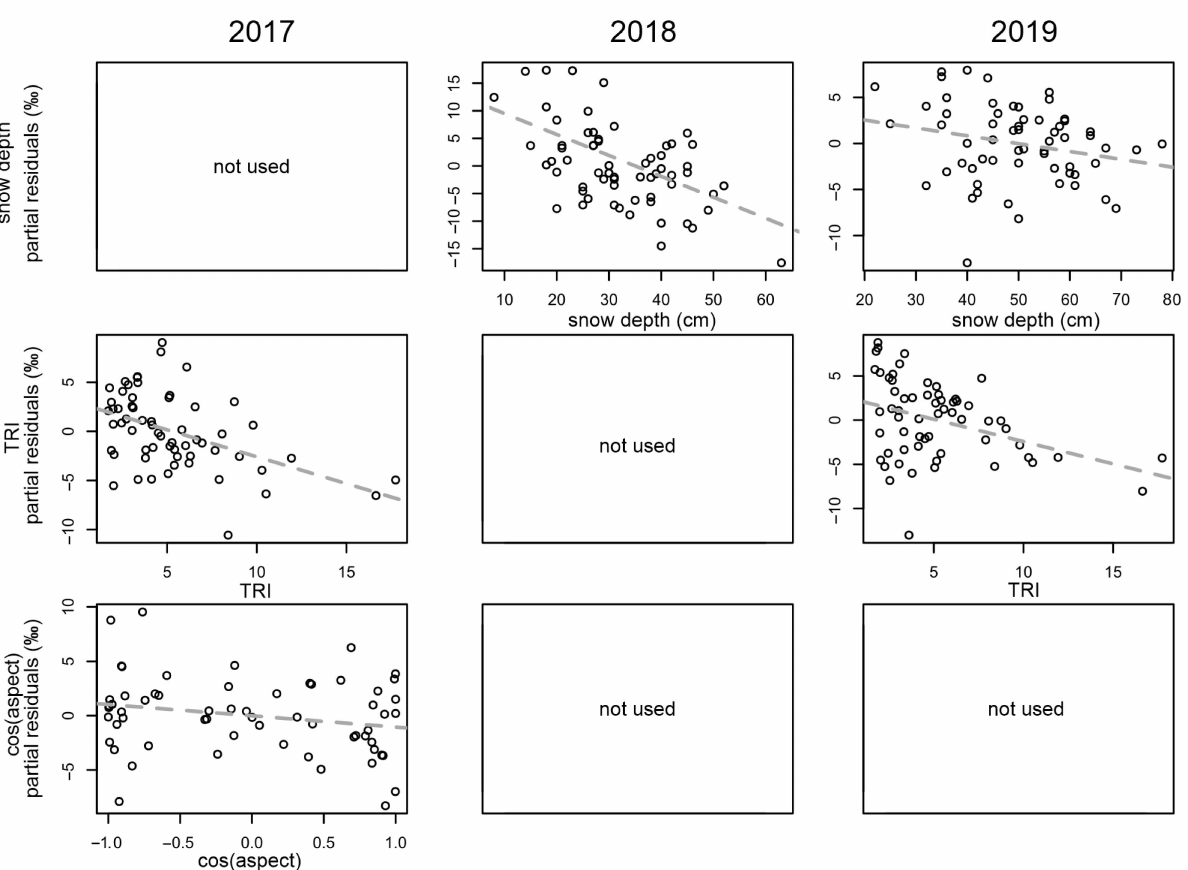
Figure 6. Partial residuals of each predictor for the sampling years selected by the stepwise multiple regression. The dashed lines represent linear